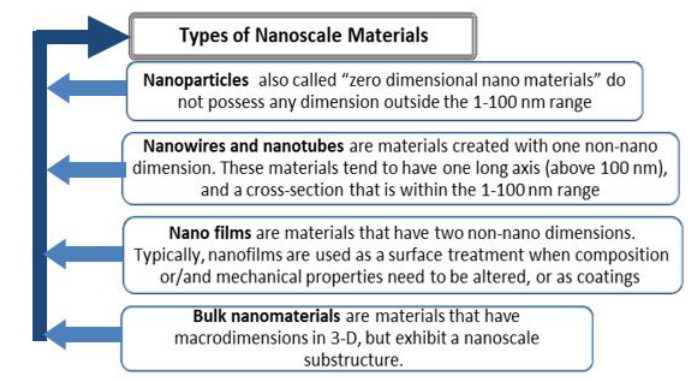
Figure 3. the types of Nano materials and their properties (Vavan, 2014) edited by the authors